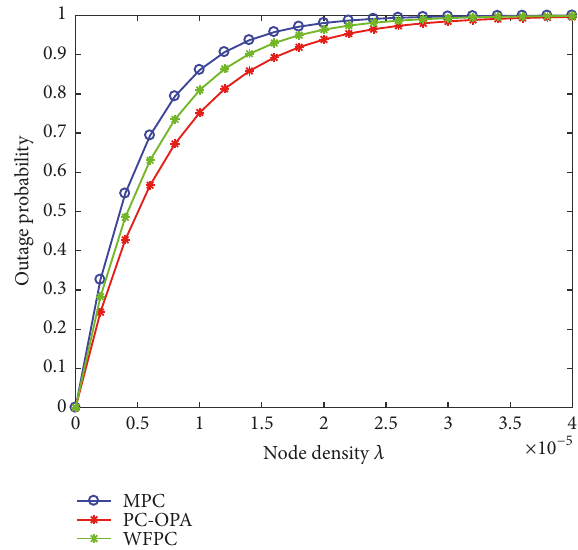
Figure 5: Outage probability versus 𝜆 density of nodes. Figure6:Outageprobabilityfordifferentalgorithmversus 𝜆 density of nodes.